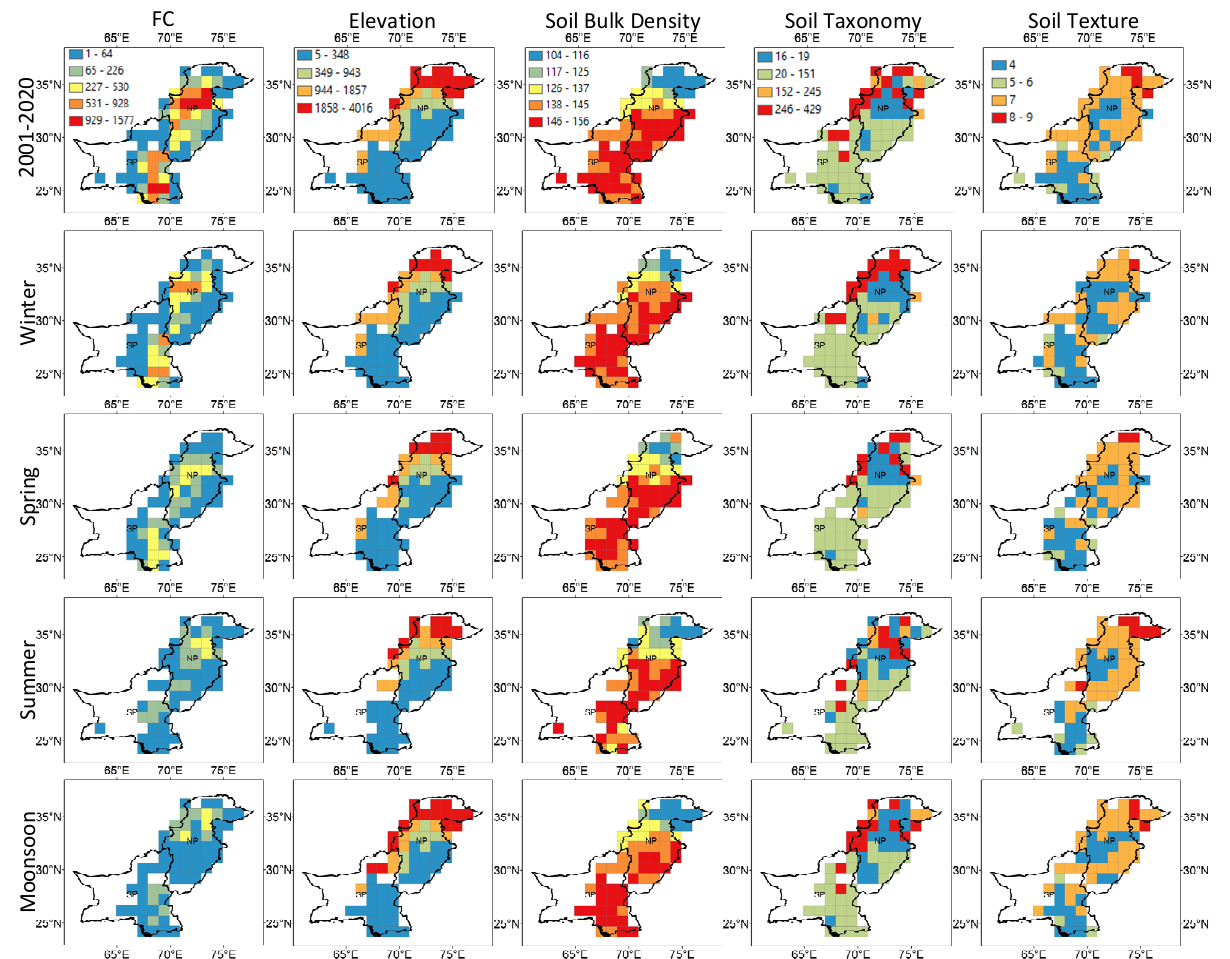
Figure 5. Spatial distributions of soil properties, and cumulated FC during 2001–2020, and for each season during the period. NP and SP indicate Northern Pakistan and Southern Pakistan, respec- tively.